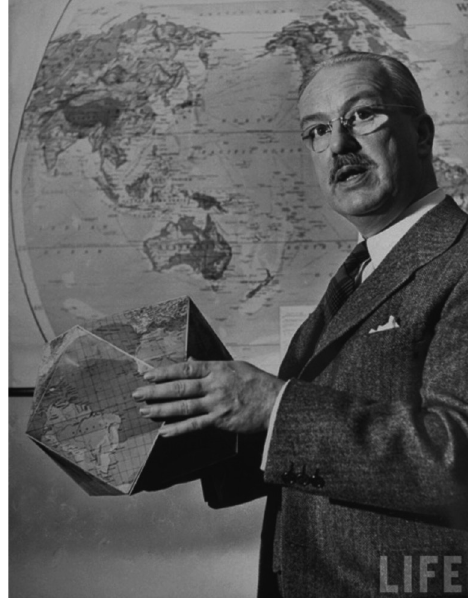
Fig. 19. R. Buckminster Fuller presenting his map on a cuboctahedron (source: R.B. Fuller 1943)